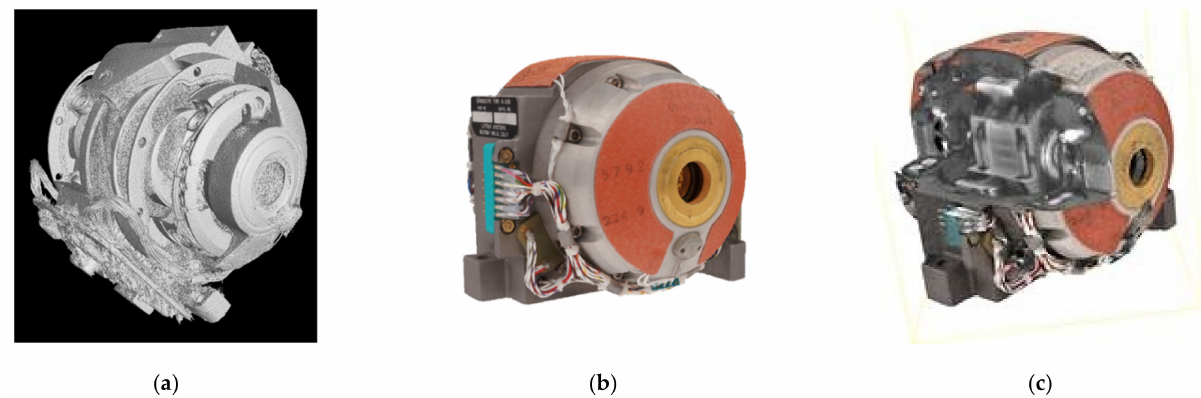
Figure 5. Example of the co-registration of CT Scans with CV/photogrammetry point clouds—the 3D digital twin of the Gyro200 (see Section 6.3): ( a ) iso-surface of a denoised filtered back projection (FBP) CT scan; ( b ) the convex hull generated by CV/photogrammetry; and ( c ) a cross-section of the integrated CT and CV/photogrammetry 3D